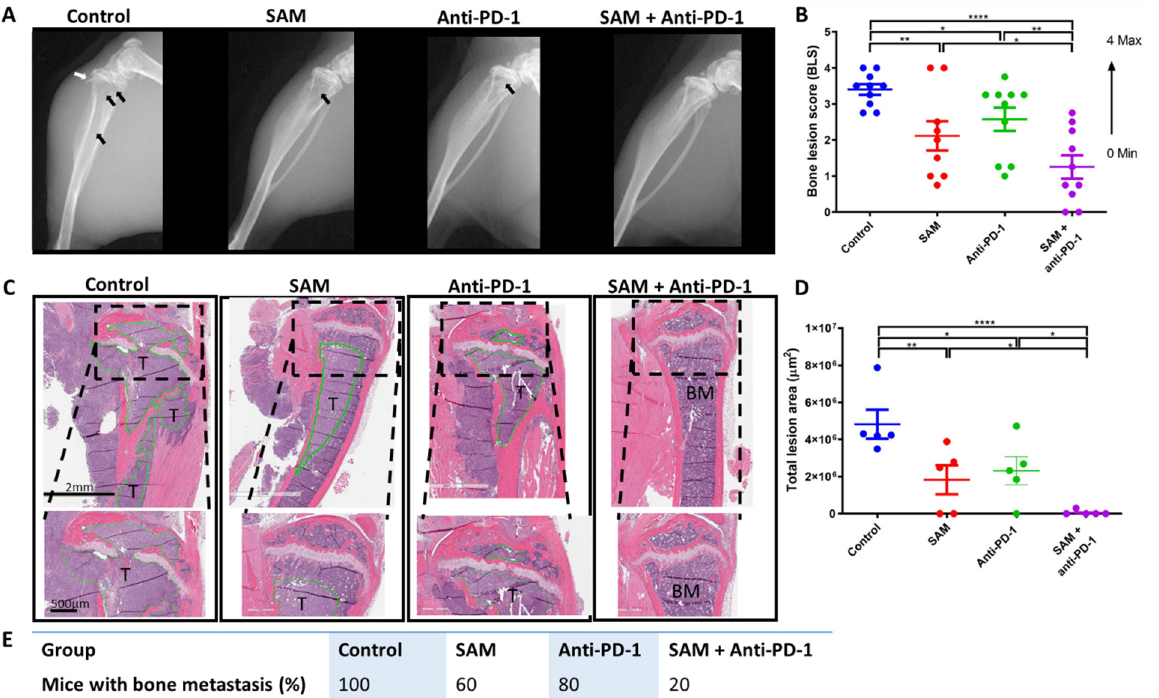
Figure 5. The SAM and anti-PD-1 antibody combination decreases bone metastasis and protects the bone from damage caused by aggressively growing tumor lesions. Briefly, mice were injected with Eo771 cells intra-tibially and treated with either control (isotype matched IgG and PBS, n = 10/group), SAM (80 mg/kg/day, n = 9/group), anti-PD-1 antibody (5 mg/kg, twice per week, n = 10/group), or the combination ( n = 10/group). ( A ) Representative X-ray images showing the anatomy of the lower limb. The tibia, fibula, and femur (in part) along with the knee joint are shown. X-rays of the mice were taken at day 21 post-tumor injection. Black arrows indicate tumors, while white arrows indicate a broken cortical bone margin. ( B ) X-ray images were used to calculate a bone lesion score (BLS) for each group in increments from 0 to 4, where 0 represents no tumor lesions with the highest bone integrity (no breaks in the peripheral margin) and 4 represents the maximum tumor lesion area with the lowest bone integrity and with major breaks in the peripheral margin ( n = 10/group, except SAM ( n = 9/group)). ( C ) Representative histology images of mouse tibias 21 days post-tumor injection. Briefly, mice were sacrificed at day 21, and tibias were extracted, fixed, decalcified, embedded, sliced, and subjected to H&E staining, as described in Materials and Methods. T, tumor; BM, bone marrow. The black bar at the bottom left represents the scale in each image: top, 2 mm; below, 500 µ m. ( D ) Total bone lesion area ( µ m 2 ) for each group ( n = 5/group). Briefly, the tumor lesion area in the whole tibia image was measured using the ImageScope annotation tool, added and plotted in GraphPad Prism. ( E ) Percentage of mice with bone metastasis in each group. Statistical significance was determined by ( B , D ) one-way ANOVA in GraphPad prism. Significance values are represented by asterisks ( * p < 0.05; ** p < 0.01; **** p <